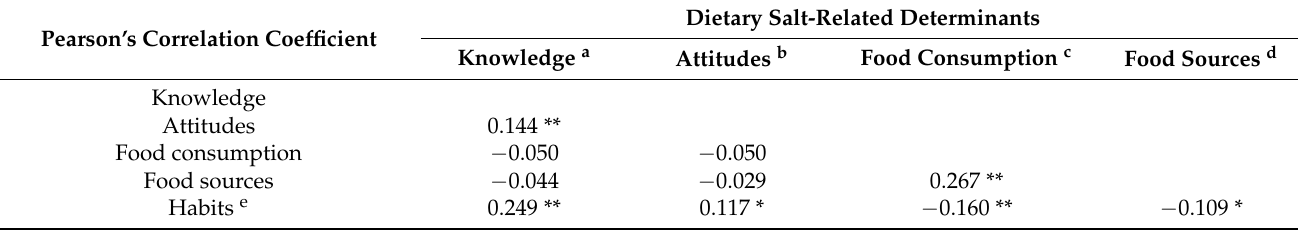
Table 7. Pearson’s correlation coefficients among dietary salt-related determinants including knowledge, attitudes, food consumption, food sources, and habits.